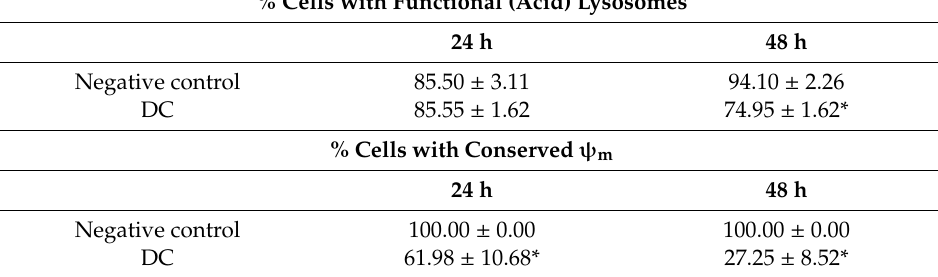
Table 2. Analysis of lysosomal and mitochondrial integrity. Above: percentages of Caco-2 cells with functional (acid) lysosomes upon 24 h and 48 h incubation with the drug combination (DC). Below: changes in mitochondrial membrane potential ( ψ m ) of Caco-2 cells after 24 h and 48 h incubation with